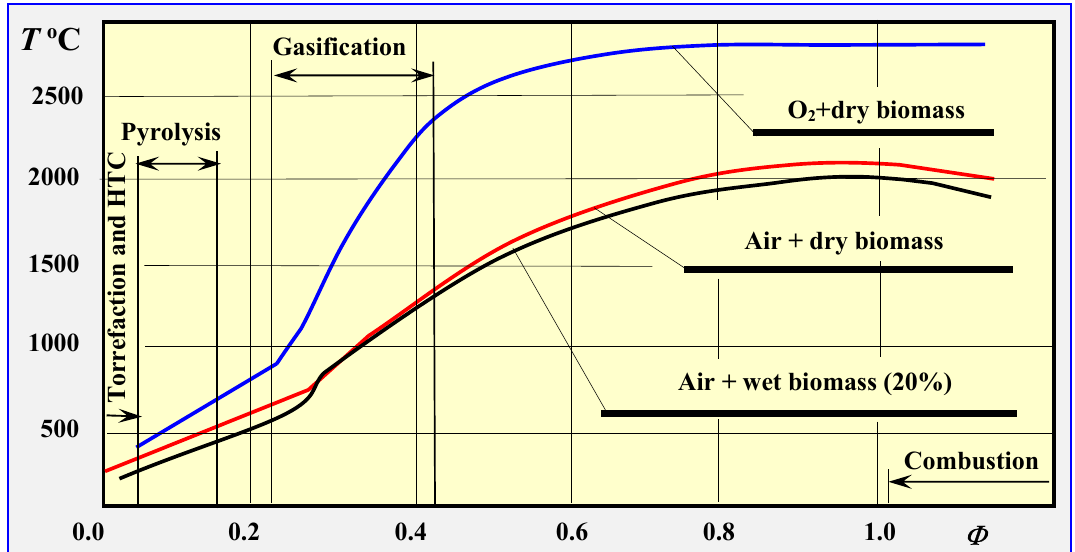
Figure 1. Impact of the amount of oxygen or air consumed, expressed by the relative oxygen factor Φ , on the thermal biomass degradation process [16], including torrefaction, hydrothermal carbonization (HTC), pyrolysis, gasification and combustion processes, based on [17]. From an ecological standpoint, the least favorable process is the combustion of biomass, and therefore only devalued waste biomass originating, e.g., from municipal waste (RDF— Refuse- Derived Fuel ) or from sewage treatment plants (screenings, activated sludge) should be utilized using this method. All other types of biomass, both full-valued and waste, should be subjected to initial thermal conversion (torrefaction, pyrolysis or gasification) before final combustion. As a